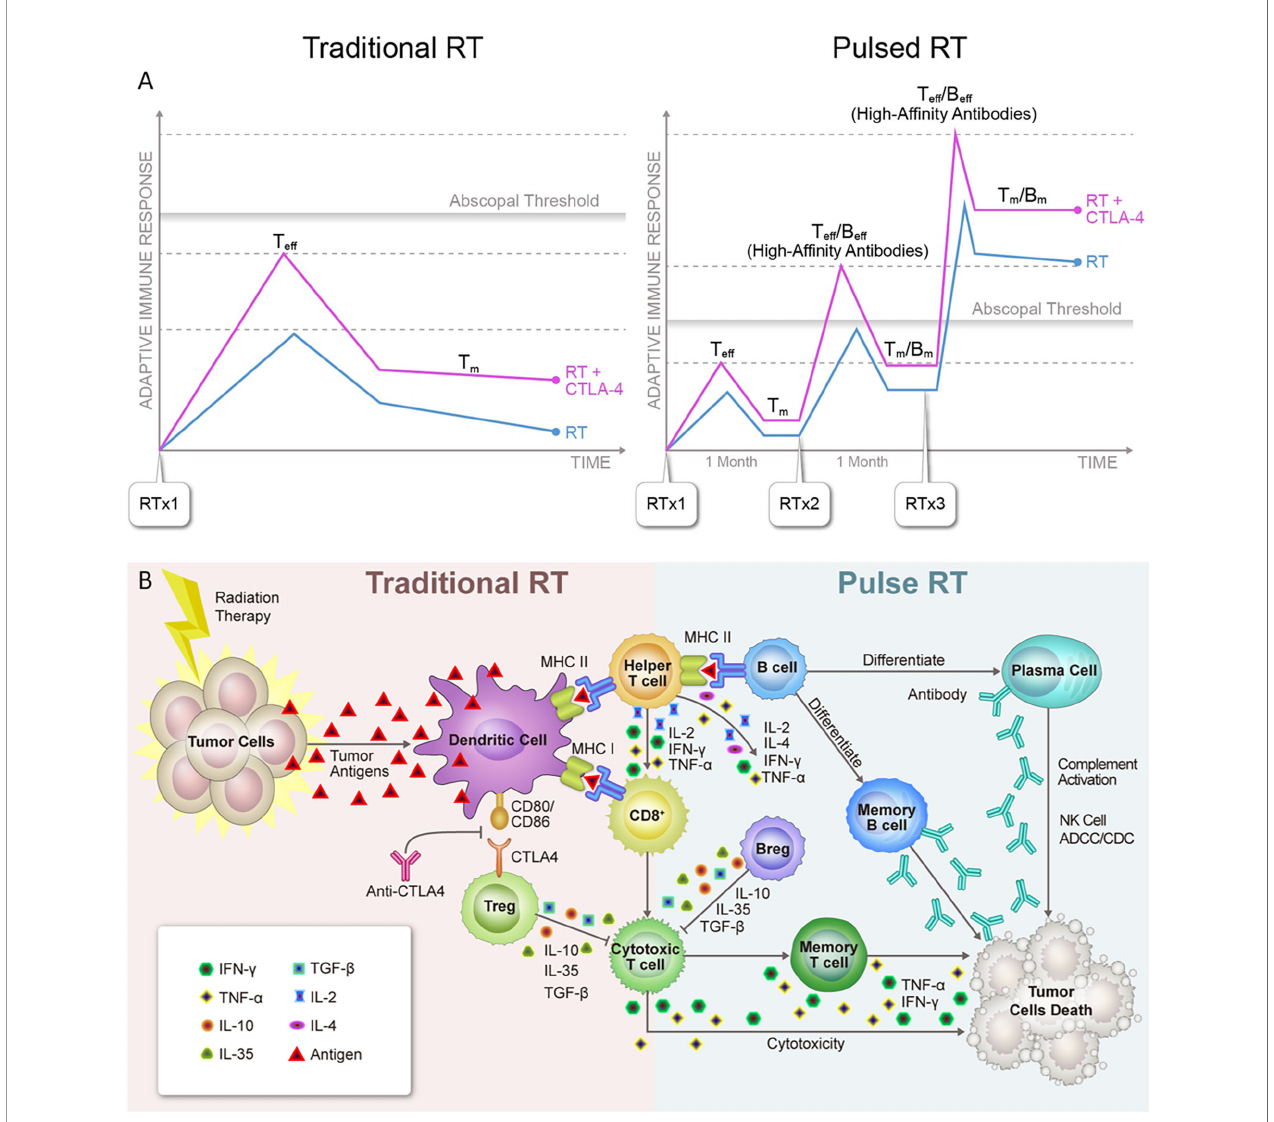
FIGURE 2 | (A) Systemic effects of traditional vs. pulsed radiation therapy with anti-CTLA4. 1). Used with traditionally fractionated radiation therapy (RT), CTLA4 inhibitors boost the activation of T-cell clones with high-af fi nity T-cell receptors (TCRs) and expand the peripheral TCR repertoire, resulting in more robust activation of tumor-reactive T-cells and formation of memory T-cells (T m ). However, this combination usually fails to reach the assumed abscopal threshold, which may explain why abscopal effects are so rarely observed in the clinic. 2). With pulsed-RT, the host immune system has a greater chance of being repeatedly exposed to the same tumor antigen, leading to immediate differentiation of memory cells into effector cells (T eff ). Similarly, memory B-cells that differentiate into plasma cells would produce 10 to 100 times the number of antibodies than were produced during the primary response. As a result, the adaptive immune response triggered by pulsed-RT would presumably reach the abscopal threshold and have a greater chance of producing systemic response, which would be further improved by the concurrent use of anti-CTLA4. (B) Schematic overview of known and hypothesized functional interactions between lymphocytes in antitumor adaptive immune responses triggered by traditional vs. pulsed radiation therapy. 1). Traditional radiation therapy (RT) induces immunogenic cell death in cancer cells, releasing tumor neoantigens and activating antigen-presenting dendritic cells (DCs), which in turn migrate to local lymph nodes. In the lymph node, activated DCs present antigens to CD8 + T-cells through MHC-I molecules and CD4 + T-cells through MHC-II molecules. Clones of activated helper T-cells produce cytokines that initiate B-cells and CD8 + T-cells, which become cytotoxic T-cells. The latter ultimately leave the lymph node and travel to sites where cells bearing the target antigen reside, initiating a cytotoxic antitumor response. Conversely, at the time of the initial response to antigen, CTLA4 expressed on regulatory T-cells (Tregs) binds to CD80/CD86 on antigen-presenting cells (APCs) and inhibits T-cell activation. 2). In pulsed-RT, the initiated B-cells mature into effector B-cells and can further differentiate into plasma cells, which can produce antibodies against tumor-speci fi c antigens. These antibodies in turn directly against their target proteins, triggering NK-cells − directed antibody-dependent cellular cytotoxicity (ADCC) or complement-dependent cytotoxicity (CDC) reactions. Effector B-cells can also enhance T-cell responses by producing stimulatory cytokines. As T and B-cells mature into effector cells, a subset of each differentiates into memory cells and can immediately become effector cells upon re-exposure to the same tumor-speci fi c antigen. As a result, a secondary exposure to a given antigen would trigger an immune response that is much more rapid and more vigorous than that seen with the fi rst pulsed-RT exposure. Conversely, regulatory B-cell (Bregs) can act in concert with Tregs to suppress antitumor immune responses. IFN, interferon; IL, interleukin; TGF, tumor growth factor; TNF, tumor necrosis